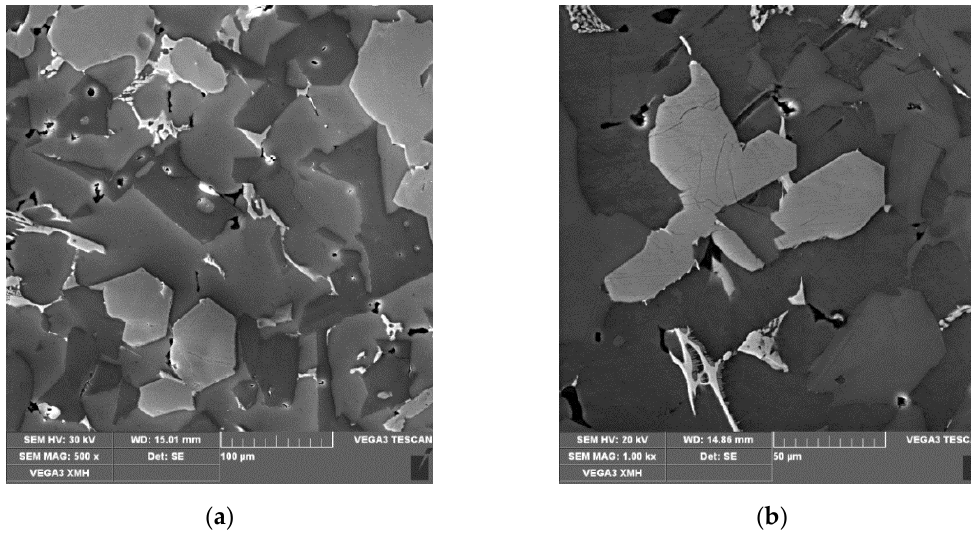
Figure 2. An example structure of hypereutectic Al-Si alloy prepared for metallographic examination, SEM, ( a ) 500×, ( b ) 1000×.